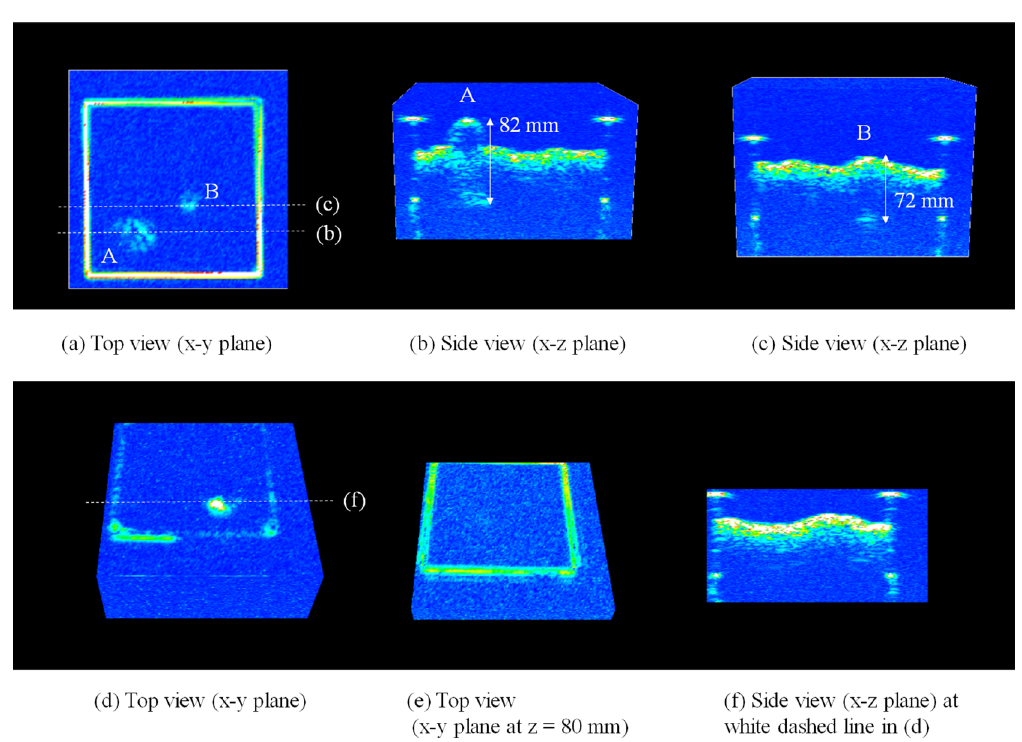
Figure 3. Cross-sectional acoustic images of the laboratory observations. ( a – c ) Experiment with Sample A and Sample B, whose reflectors are labelled A and B, respectively: ( a ) Top view showing the sediment surface. ( b ) Side view at the position of the white dashed line ( b ) in ( a ). ( c ) Side view at the white dashed line ( c ). ( d – f ) Experiment with Sample C and Sample D: ( d ) Top view around the sediment surface. ( e ) Top view at 80 mm depth from the sediment surface. ( f ) Side view at the white dashed line ( f